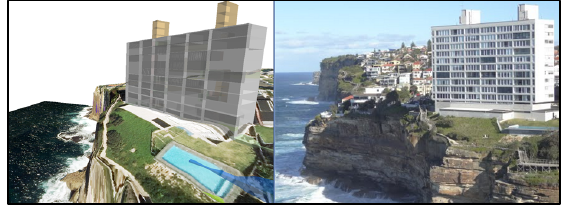
Figure 9: Captured model vs real life. Image on right “Diamond Bay – Ugly Building” © Google Maps